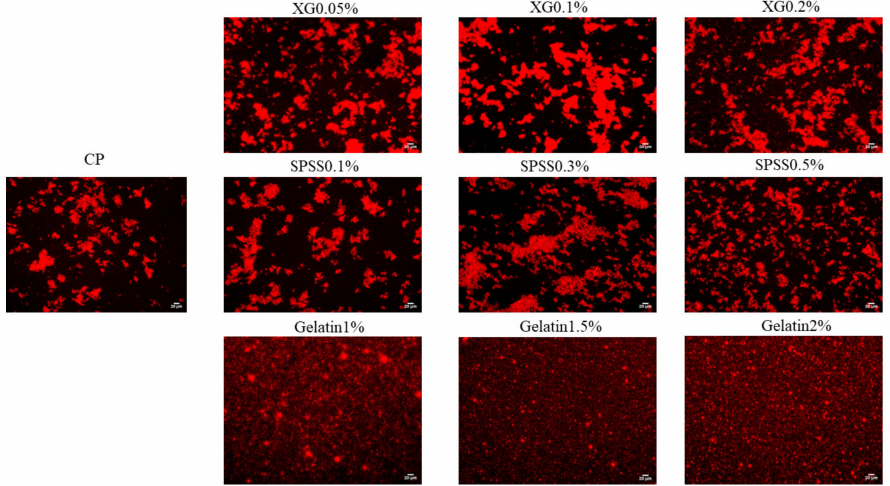
Figure 10. Effect of XG, SSPS and gelatin on the microstructure of emulsions samples. (CP-Coconut protein, XG-Xanthan gum, SSPS-Soluble soybean polysaccharide).